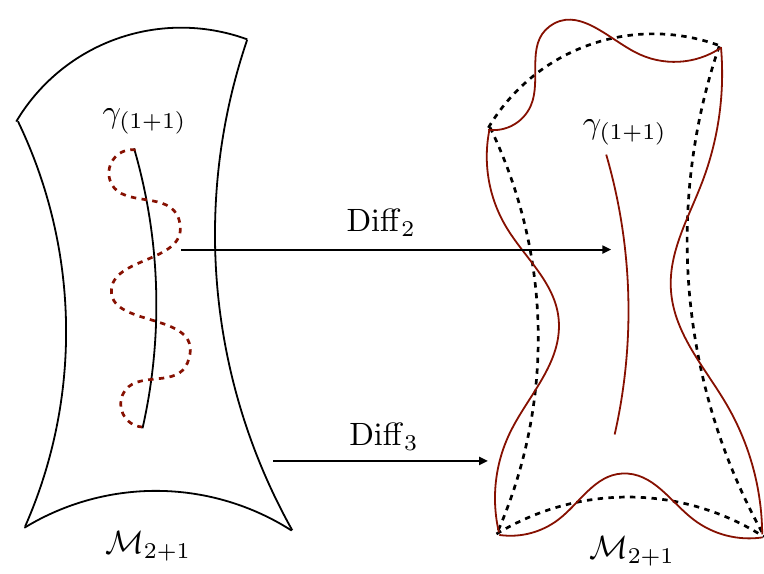
Figure 4 . A cartoon demonstrating how Di(cid:11) 2 can be obtained from a Di(cid:11) 3 . The left dashed curve represents a (cid:13)uctuating worldsheet, embedded in an AdS 3 . If the (cid:13)uctuation belongs to the soft sector, then a Di(cid:11) 2 can be used to map the (cid:13)uctuating worldsheet back to the classical